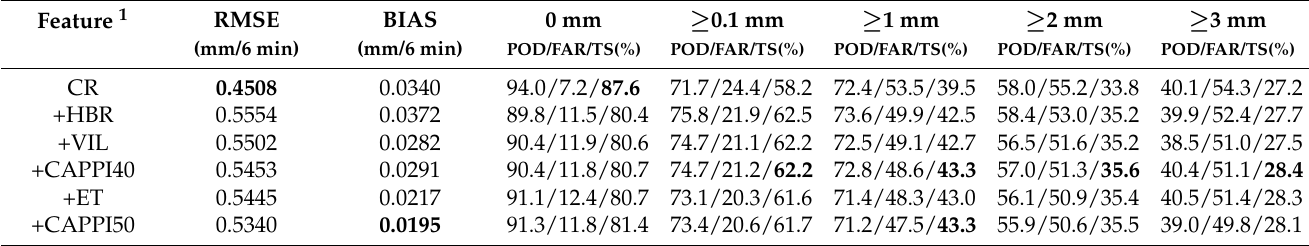
Table 6. Comparison of different radar feature combinations as input. Bold indicates that the best indicator in the current list.